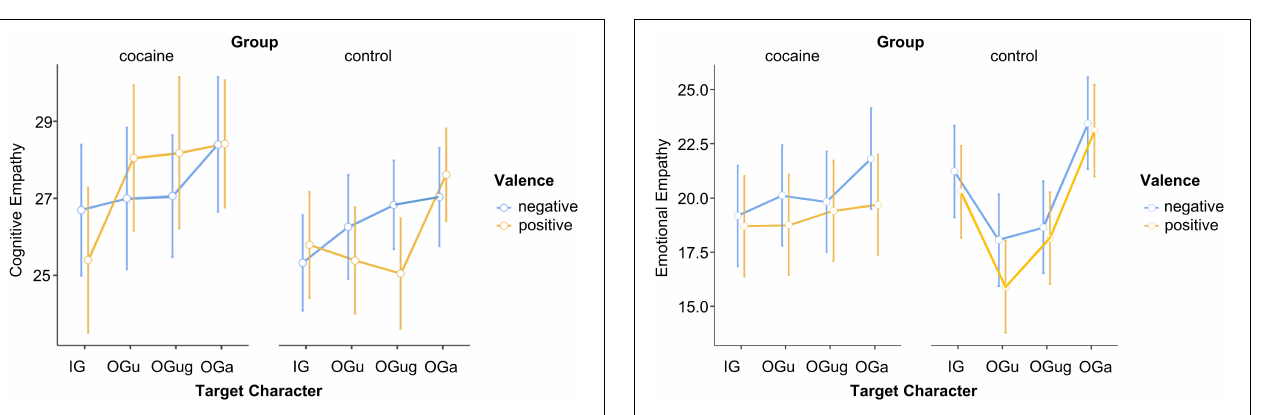
FIGURE 6 | Emotional empathy expressed for the different social targets. IG, in-group; OG u , out-group use; OG ug , out-group use + gender; OG a , out-group age. Error bars, standard